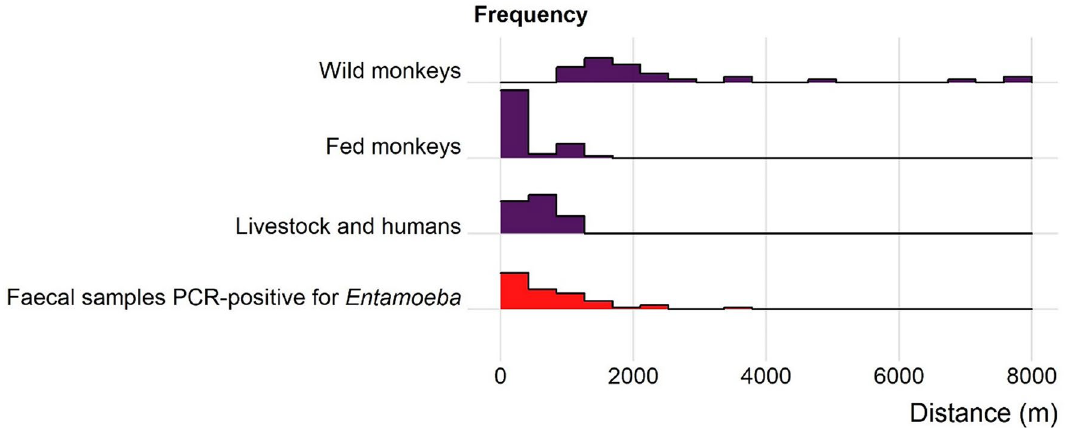
Figure 11. Frequency of faecal samples and Entamoeba PCR-positivity as a function of distance to the centroid of locations where livestock and human faeces were Data availability